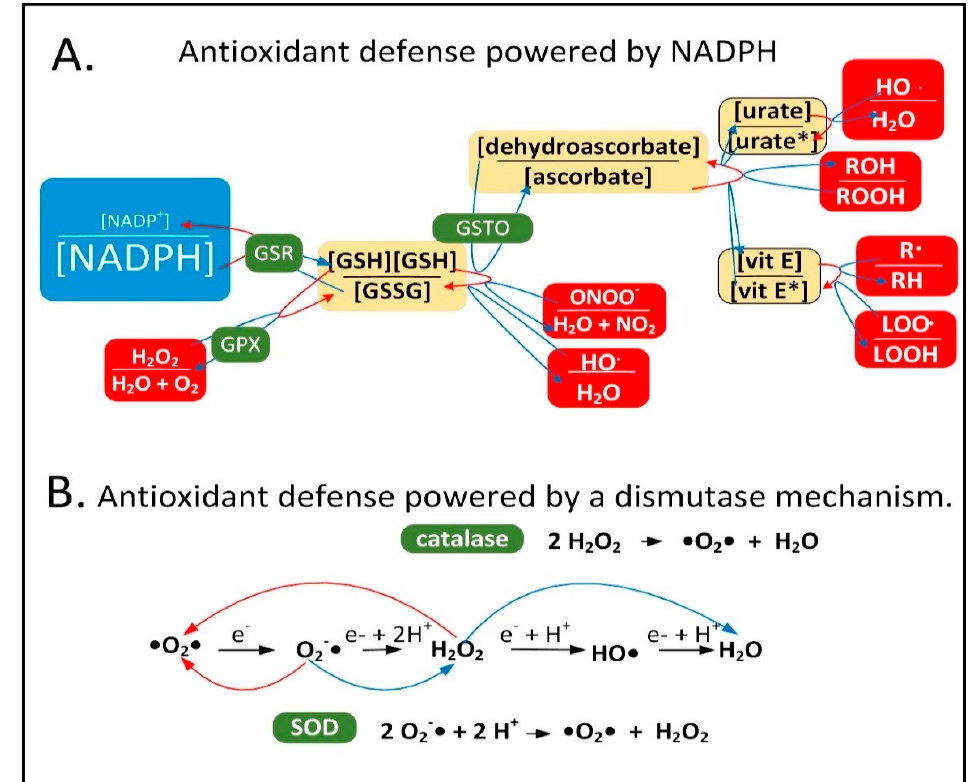
Figure 1. Cellular antioxidants that use NADPH for reduction compared to those that use a dismu- tase mechanism. ( A ) NADPH provides electrons to the antioxidant system to detoxify ROS/RNS. Abbreviations: oxidized glutathione disulfide (GSSG), hydrogen peroxide (H 2 O 2 ), dehydroascorbate (oxidized form of vitamin C), peroxynitrite (ONOO − ), hydroxyl radical (HO • ), oxidized urate radical (urate*), oxidized vitamin E radical (vit E*), alkyl peroxide (ROOH), alkyl free radical (R • ), lipid peroxide radical (LOO • ) glutathione reductase (GSR), glutathione peroxidase (GPX), dehydroascor- bate reductase (GSTO). ( B ) The dismutase mechanism of SOD and catalase uses two reactants (either two O 2 •− or two H 2 O 2 molecules) and leads to the reduction of one and the oxidation of the other. Abbreviation: superoxide dismutase